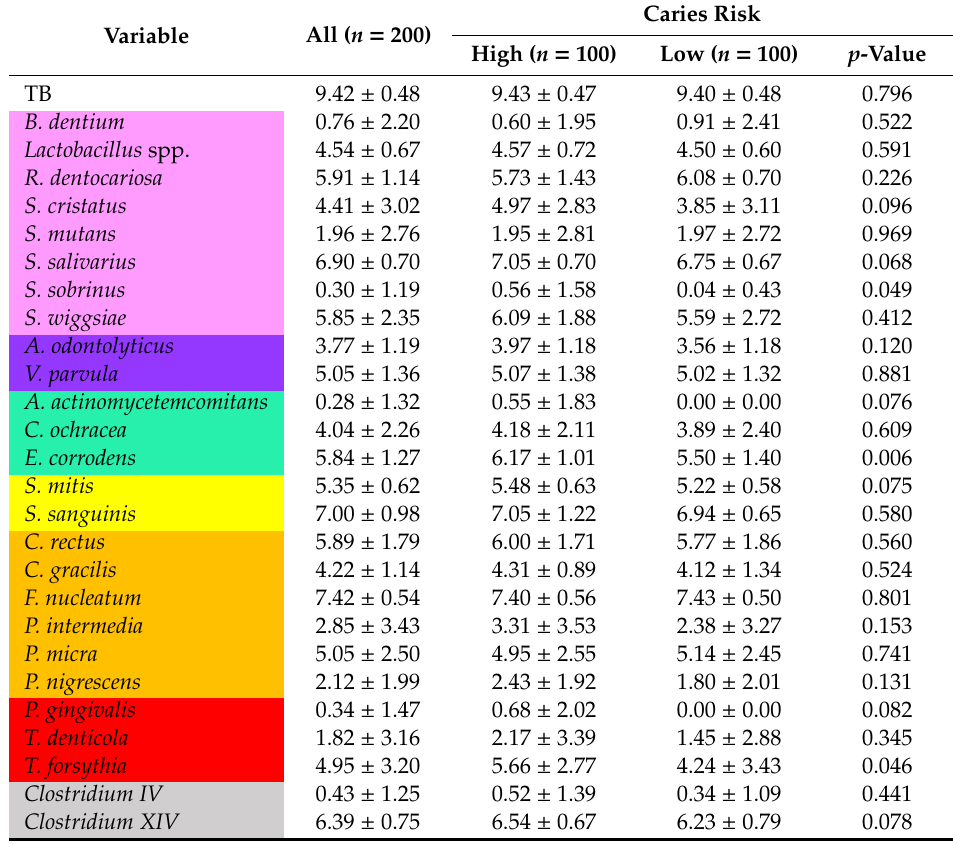
The colors refer to (i) the colors of the Socransky complexes for the purple, green, yellow, orange, and red colors, (ii) cariogenic bacteria for the pink color and (iii) bacteria from the clostridium group for the gray